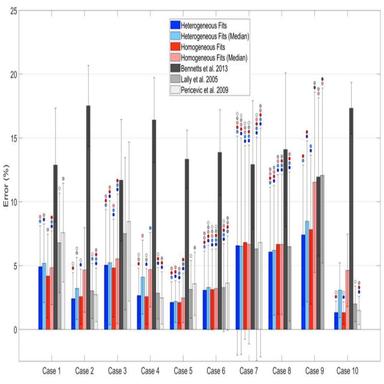
A comparison of the mean error (�standard deviation) for each case for the fitted parameters in this study) and for constitutive models from three previous studies. Bars marked with a circle are not significant with respect to the bar of the same color as the asterisk.